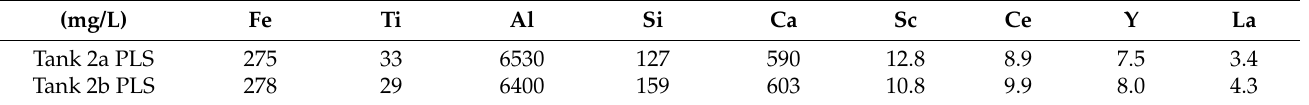
Table 3. Main metal concentration in the PLS prior to loading to the SIR column (two 5 m 3 tanks).